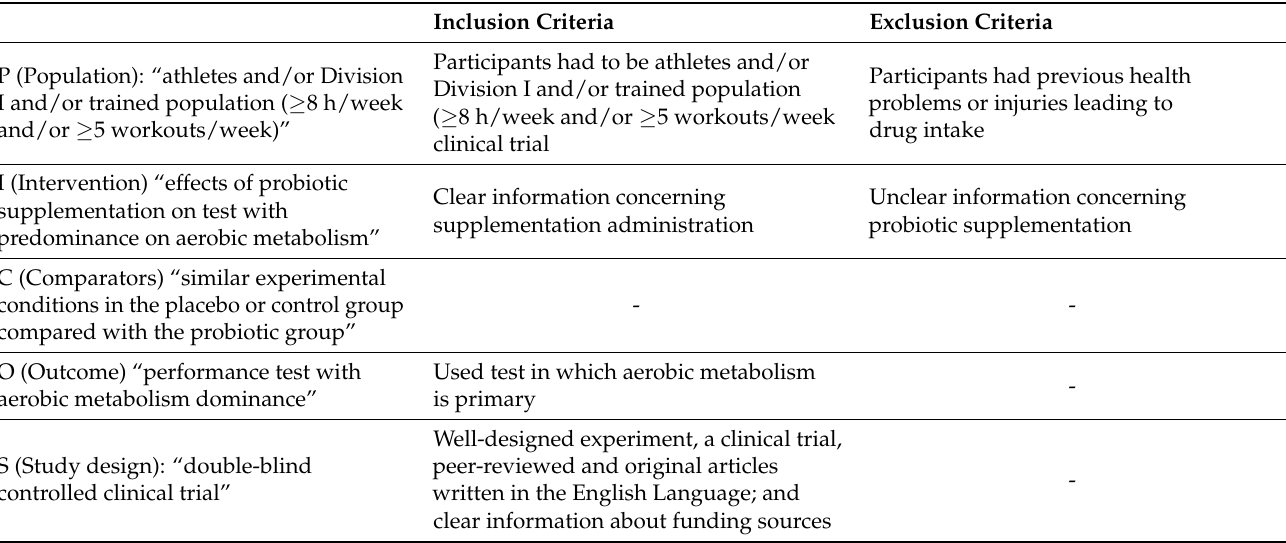
Table 1. Inclusion and exclusion criteria following each point of